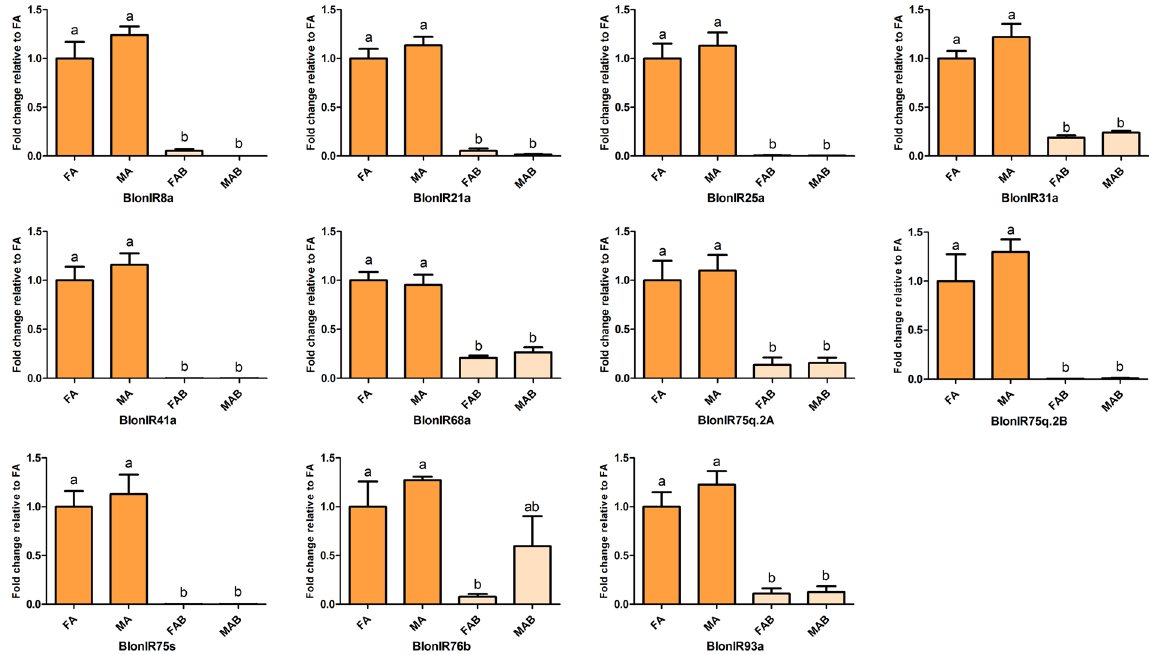
Figure 4. Relative expression levels of antennal IRs using qPCR. FA, female antennae; MA, male antennae; FAB, female terminal abdomens; MAB, male terminal abdomens. The relative expression level is indicated as mean ± SE (N = 3). Different letters indicate significant differences between tissues (P < 0.05, ANOVA,